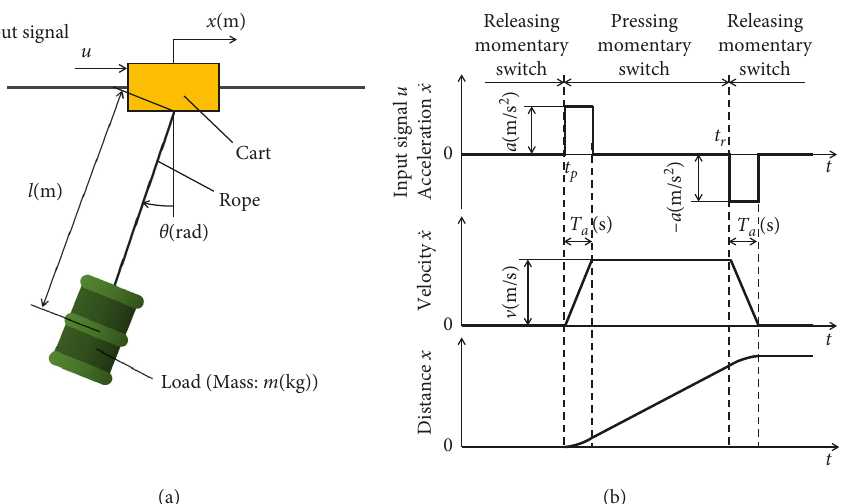
Figure 3: Overview of the overhead traveling crane model with operating momentary switches. (a) Illustration of crane model. (b) Cart motion operated by momentary